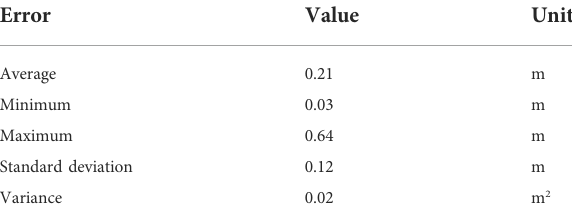
TABLE 1 Task 1: Statistical indexes of the estimation errors in the positions of the